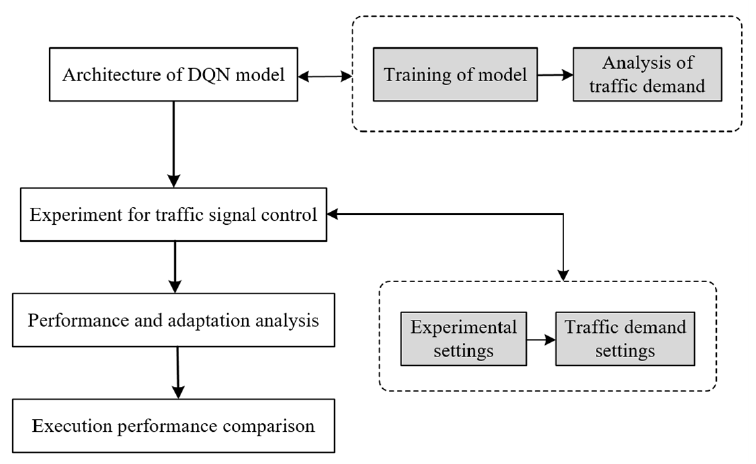
Figure 1. Overall framework of the